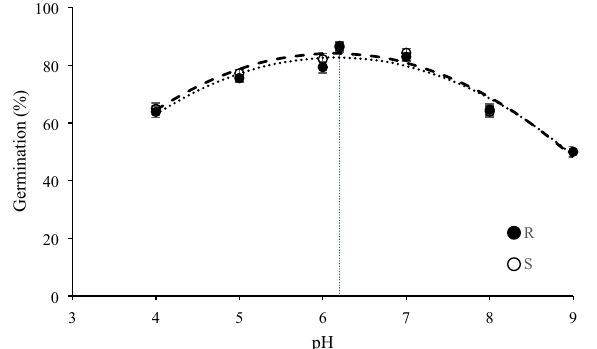
Figure 4. Germination of herbicide-resistant (black circles) and -susceptible (white circles) winter wild oat biotype as affected by different pHs. The dotted vertical line shows the pH of distilled water (pH = 6.2). The data